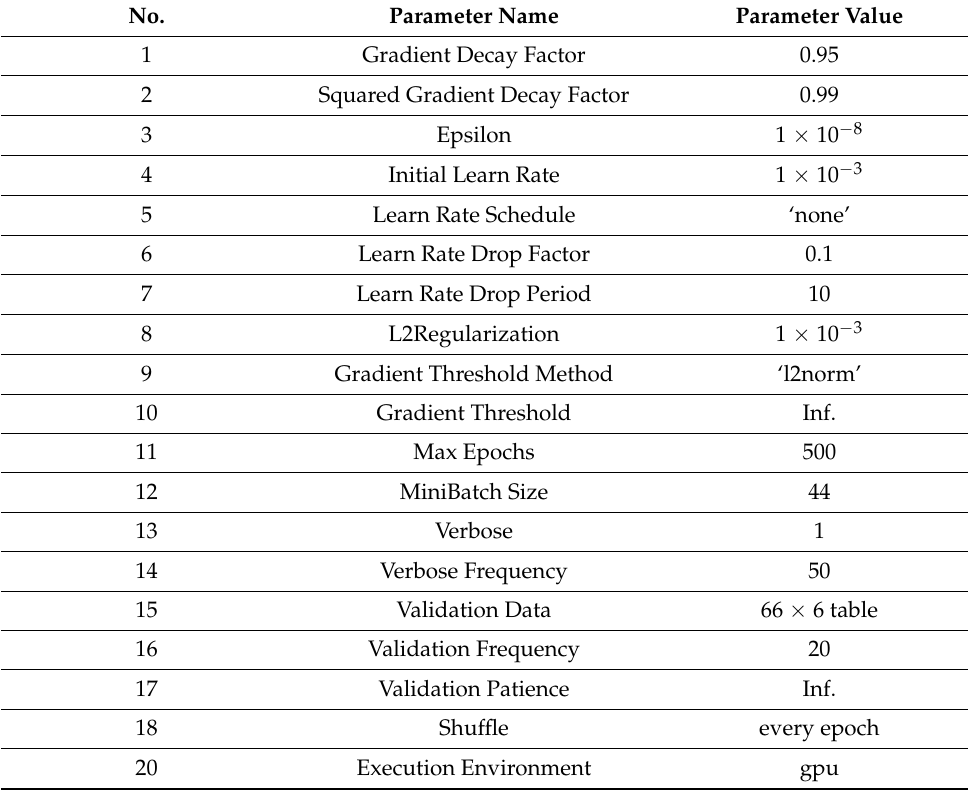
Table 5. Parameters used in network training and validation process.